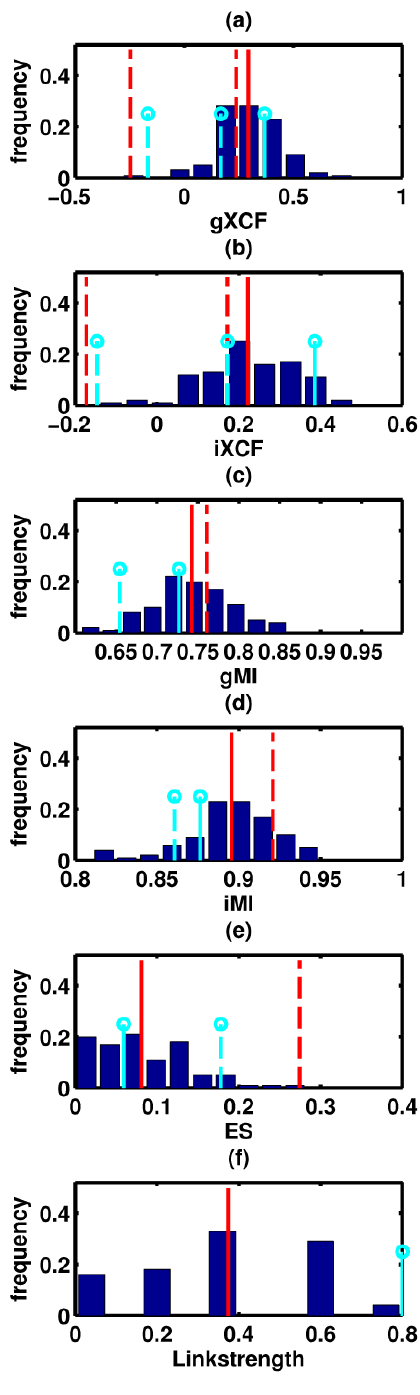
Fig. 8. Estimated lag zero similarities and link strength between the Dandak and Wanxiang cave records for the overlapping time period. The results for the age-uncertain ensembles are given in the dark blue histograms. The red solid line refers to the mean of these estimates, the light blue stem to the results for the mean timescale. The dashed lines refer to the respective confidence